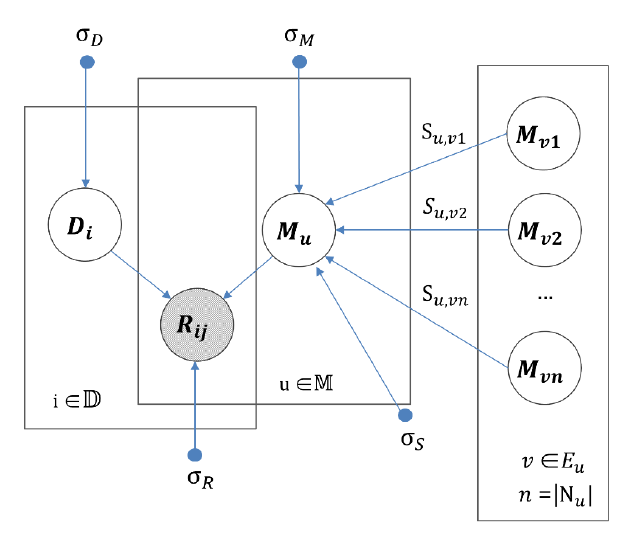
Figure 2. Graphical modeling of IMDN.